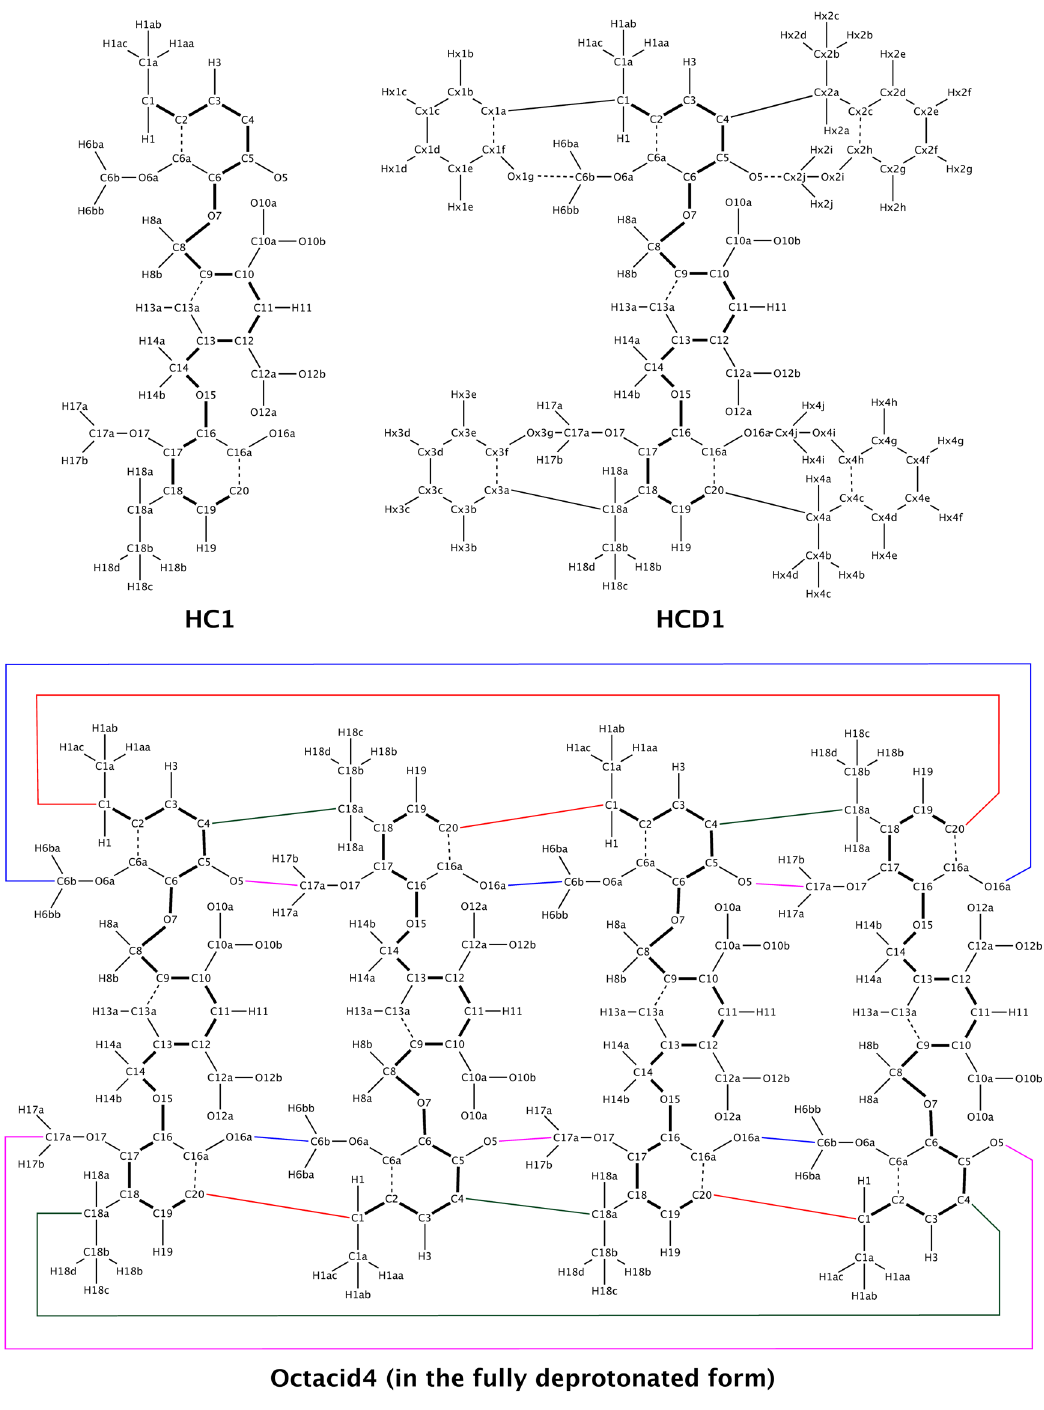
Fig. 3 Chemical structures of HC1 and HCD1 and the assembly of HC1 into the octa-anionic Octacid4. Thick lines indicate the bonds between main-chain atoms. Thin lines indicate the bonds between side-chain atoms or between a main-chain atom and a side-chain atom. Thin dashed lines and colored lines indicate the respective intra- and inter-residue bonds that are constructed with cross-links. The double bonds and net charges are not displayed for